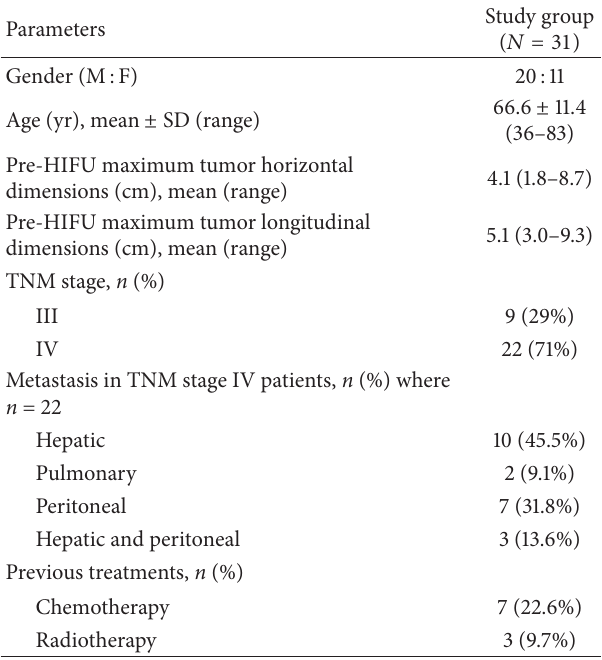
Table 1: Demographics and clinical condition of the